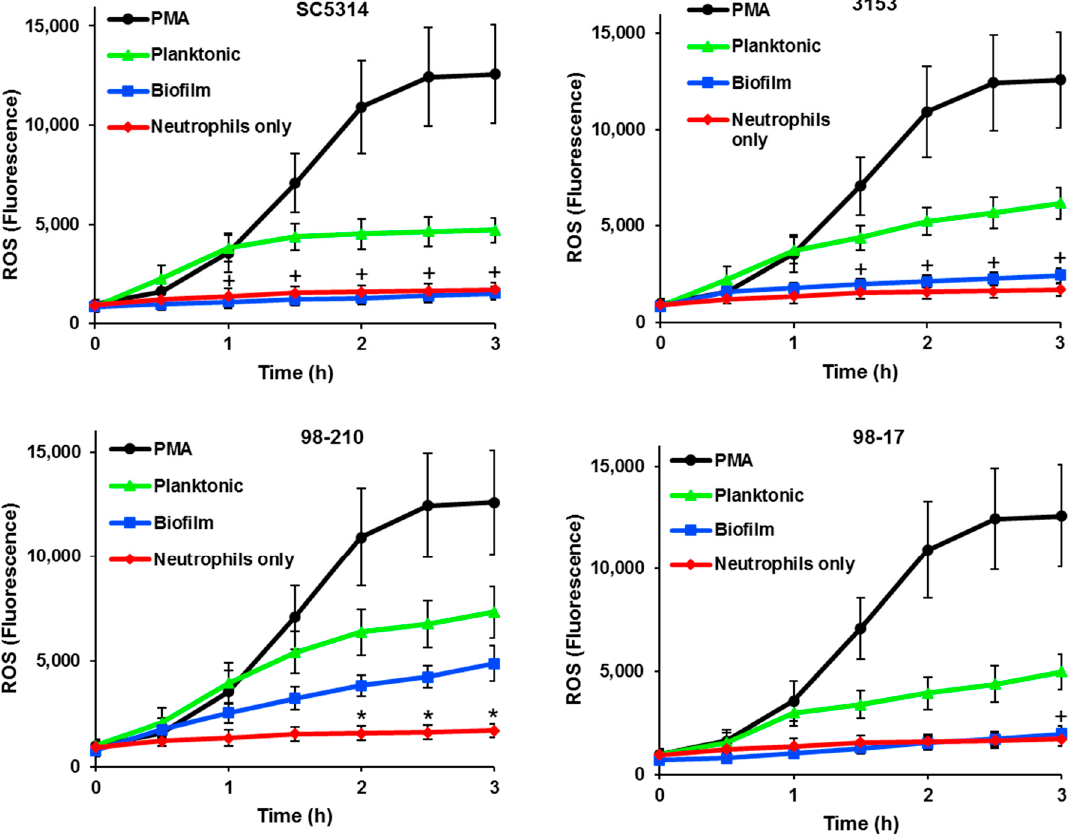
Figure 3. ROS production by neutrophils exposed to planktonic and biofilm C. albicans . ROS generation was estimated by fluorescence after neutrophils pre-stained with CMH(2)CFDA were co-cultured with clinical isolates. ROS production by neutrophils exposed to biofilms was compared to neutrophils only or planktonic cells at each time point using a Student’s t -test, * p < 0.05 biofilm vs. neutrophils only; + p < 0.05 biofilm vs. planktonic, n = 3, SEM shown.